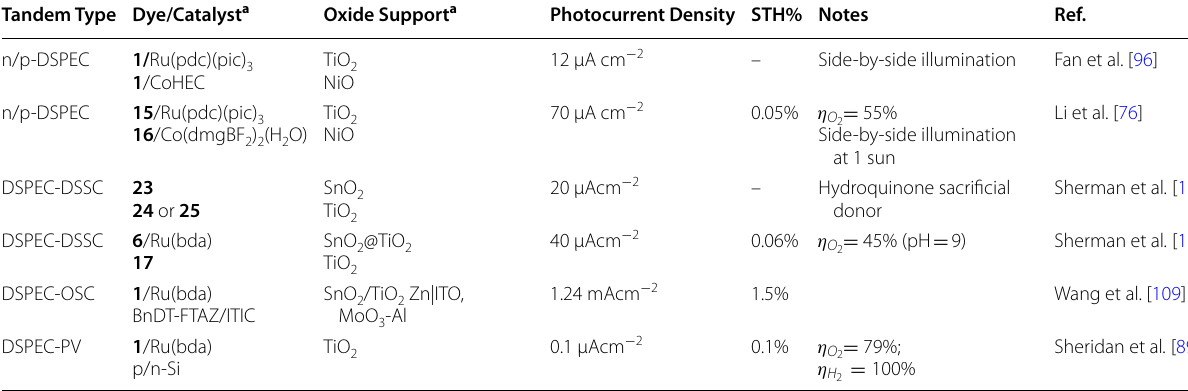
a Photoanode components listed first, photocathode second for n/p-DSPECs. More-blue absorbing junction listed first, more-red absorbing junction listed second for DSPEC-DSSCs